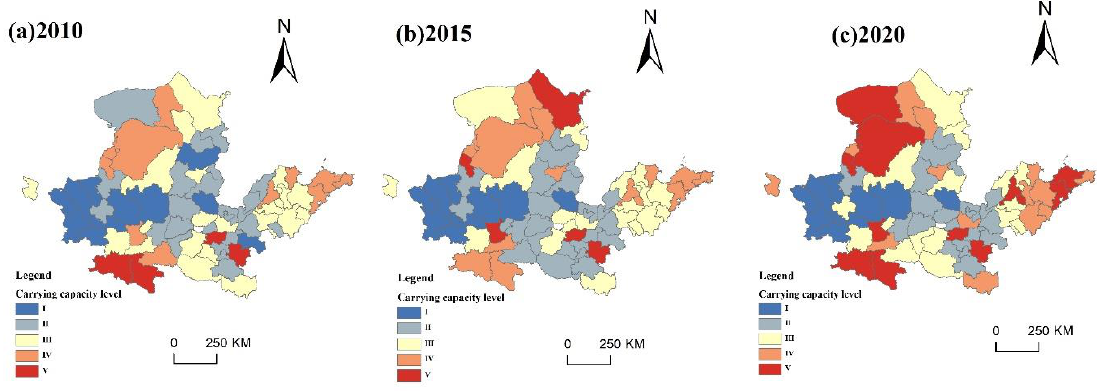
Figure 7. Spatial and temporal patterns of living carrying capacity from 2010 to 2020.